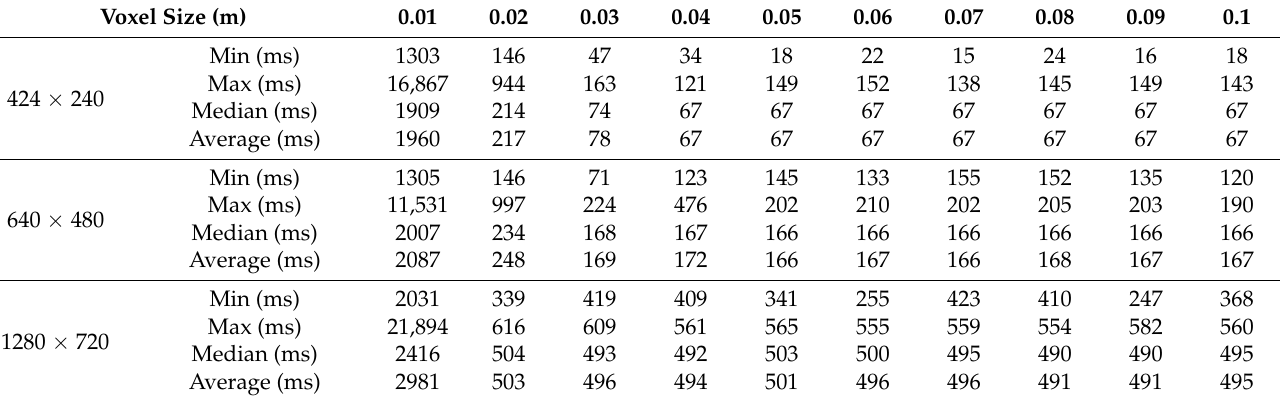
Table 1. Time required to process the whole scene with three cameras for various voxel sizes and camera resolutions using the centralized approach.